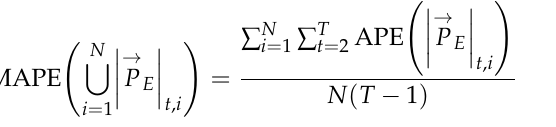
Table 6. Monitored coordinates of markers.